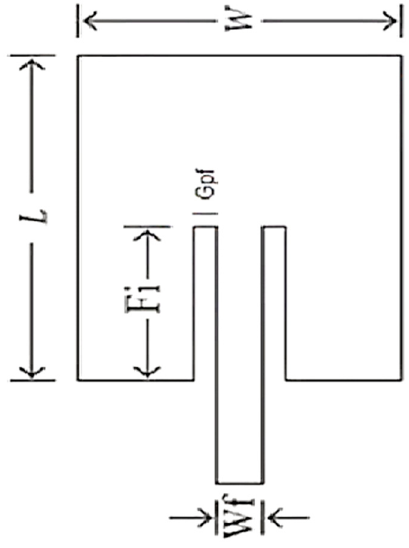
Figure 5. Structural diagram of E-shaped microstrip antenna.